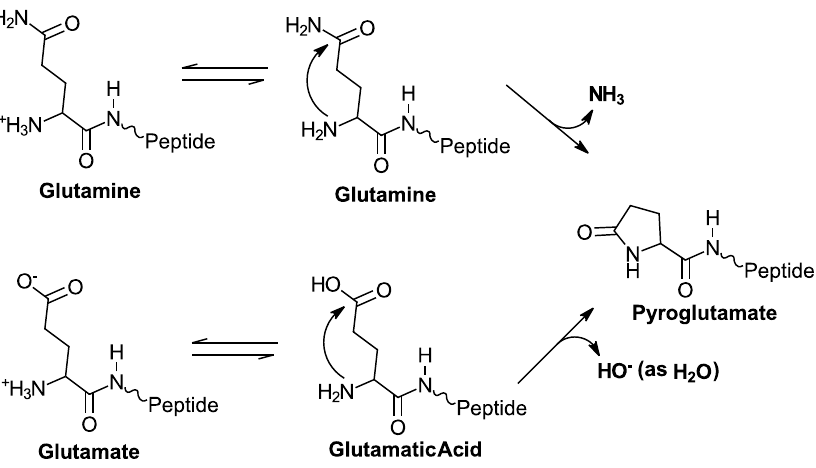
Figure 1. Cyclization reactions of N-terminal glutamine and glutamate residues in a polypeptide chain. Conditions such as pH are important factors in the rate of cyclization; low pH leads to a higher proportion of a good leaving group, while high pH leads to better nucleophilicity in the attacking amino group [22,26].